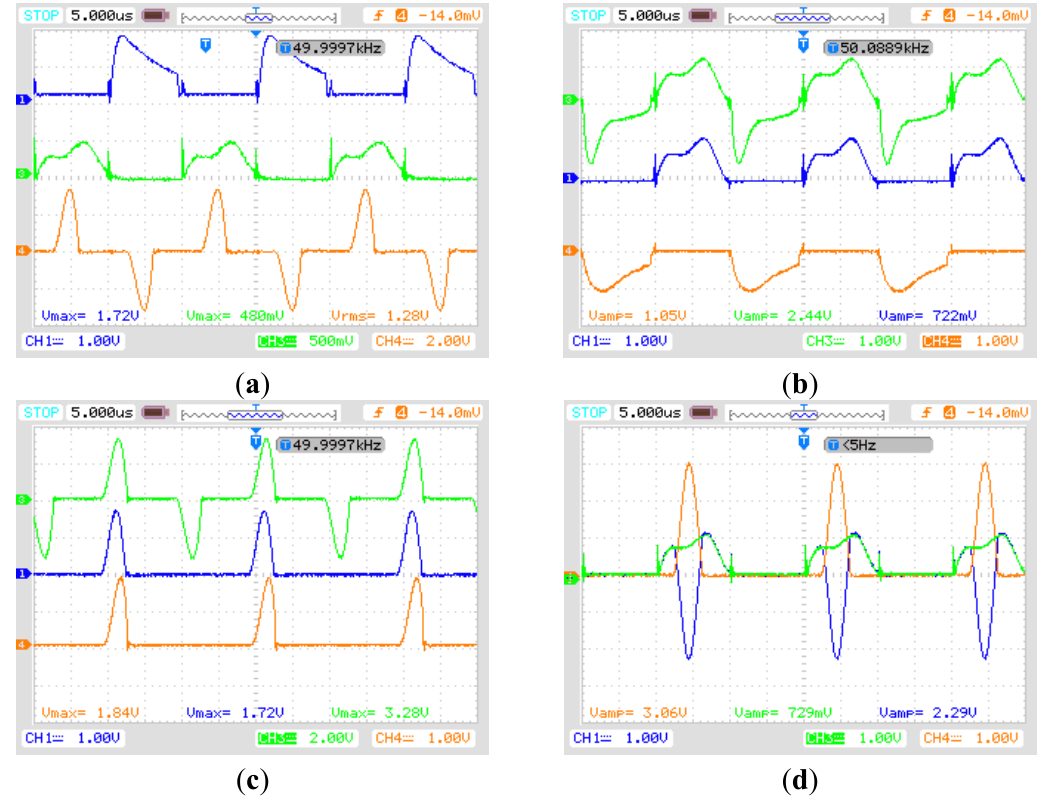
Figure 11. The waveform of current flowing through resonant inductor, diode and capacitor (load resistance is 100 Ω ). ( a ) Ch1: inductor current i Lr3 (1 A/div); Ch3: inductor current i Lr2 (500 mA/div); Ch4: i Lr1 (2 A/div); ( b ) Ch1: inductor current i Lr2 (1 A/div); Ch3: current flowing through C3 (1 A/div); Ch4: current flowing through D3 (1 A/div); ( c ) Ch1: current flowing through D 4 ′ (1 A/div); Ch3: inductor current i Lr1 (2 A/div); Ch4: current flowing through D 2 ′ (1 A/div); ( d ) Ch1: current flowing through C 4 ′ (1 A/div); Ch3: inductor current